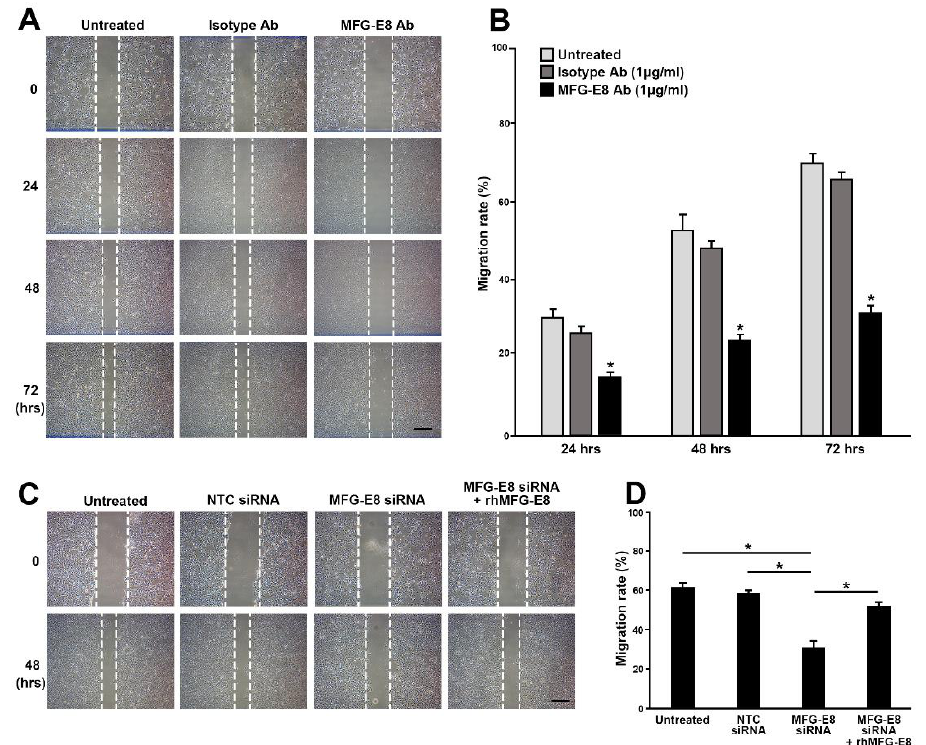
Figure 5. HCC cells migration after inhibiting MFG-E8 activity and silencing the expression of MFG-E8. ( A ) Migration of Huh7 cells treated with either isotype IgG or anti-MFG-E8 antibody was evaluated by a scratch assay; phase-contrast images were taken 24, 48, 72, and 96 h after making the mechanical scratch wound in vitro. The migration rates are shown in ( B ). ( C , D ) Migration of Huh7 after transfection with siRNA-MFG-E8 was analyzed in the absence or present of recombinant human MFG-E8 proteins (rhMFG-E8). The comparison of the migration rate is shown in ( D ). Data represent the mean ± S.D. * p < 0.05, a two-tailed Student’s t -test. Scale bars, 200 μm.